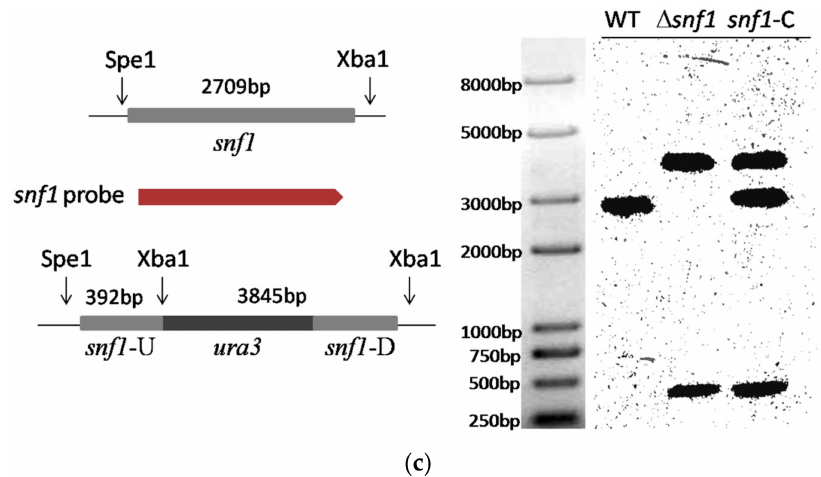
Figure 1. Identification and deletion of snf1 in Pestalotiopsis microspora NK17. ( a ) Schematic diagram of the structure of Snf1 protein from P. microspora NK17 and amino-acid sequence (partial sequence) alignments of Snf1 homologs from Saccharomyces cerevisiae . Numbers indicate the length and the location of the conserved domain of the protein, including kinase domain (KD) and C-terminal domain (CTD). The overall percentage of amino acid sequence identity with ScSnf1 is shown on the right. The identical amino acids are starred and highlighted in blue and the less conserved amino acids are shown in turquoise; ( b ) The disruption cassette on the vector pOSCAR-URA-Snf1 carried the homologous fragments of snf1 . Bottom panel showed the polymerase chain reaction (PCR) verification of the deletion in the mutants. Two fragments, 3.9 kb and 2.8 kb, were obtained by PCR amplification for ∆ snf1 , while no band was seen for NK17; ( c ) The left panel, the wild-type copy that was reintroduced in the deleted strain ∆ snf1 was shown. And the probe used in Southern blotting (the right panel) was highlighted in red. Southern blot was shown on the right to confirm the deletion of snf1 . Genomic DNAs from NK17, ∆ snf1 and the complementation strain snf1-C were digested with Spe I and Xba I. The probe used for Southern blotting was amplified by primers Snf1-up (F) and Snf1-down (R). Two bands on the membrane, at 0.4 and 3.8 kb, were obtained for ∆ snf1 , while in wild-type (WT) NK17, one band of 2.7 kb was observed. In the complementation strain snf1-C , there were three bands (0.4, 2.7 and 3.8